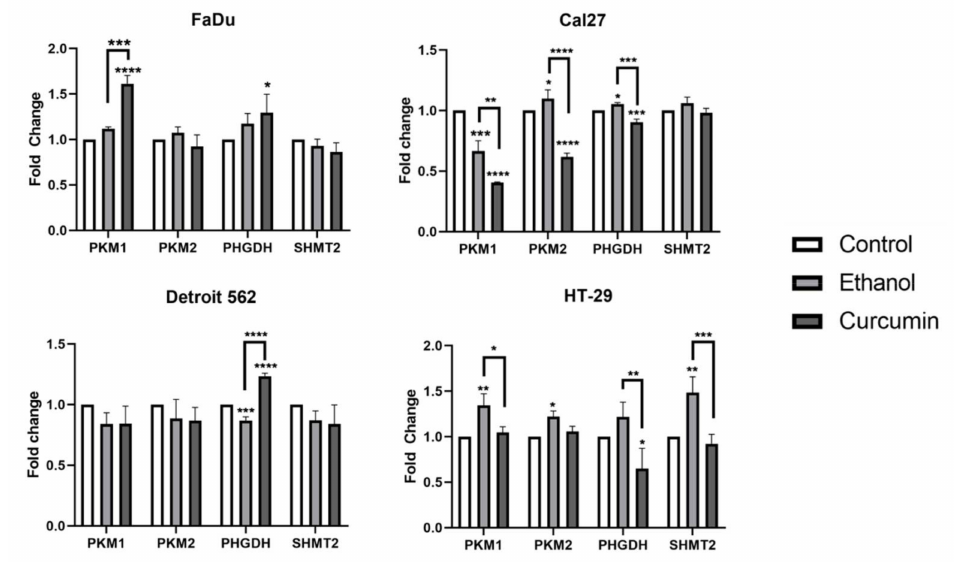
Figure 7. The e ff ect of ethanol and curcumin on transcription of PKM1, PKM2, PHGDH and SHMT2 in four di ff erent cancer cell lines. One-way ANOVA with Tukey post-hoc test. * p < 0.05; ** p < 0.01; *** p < 0.001; **** p <